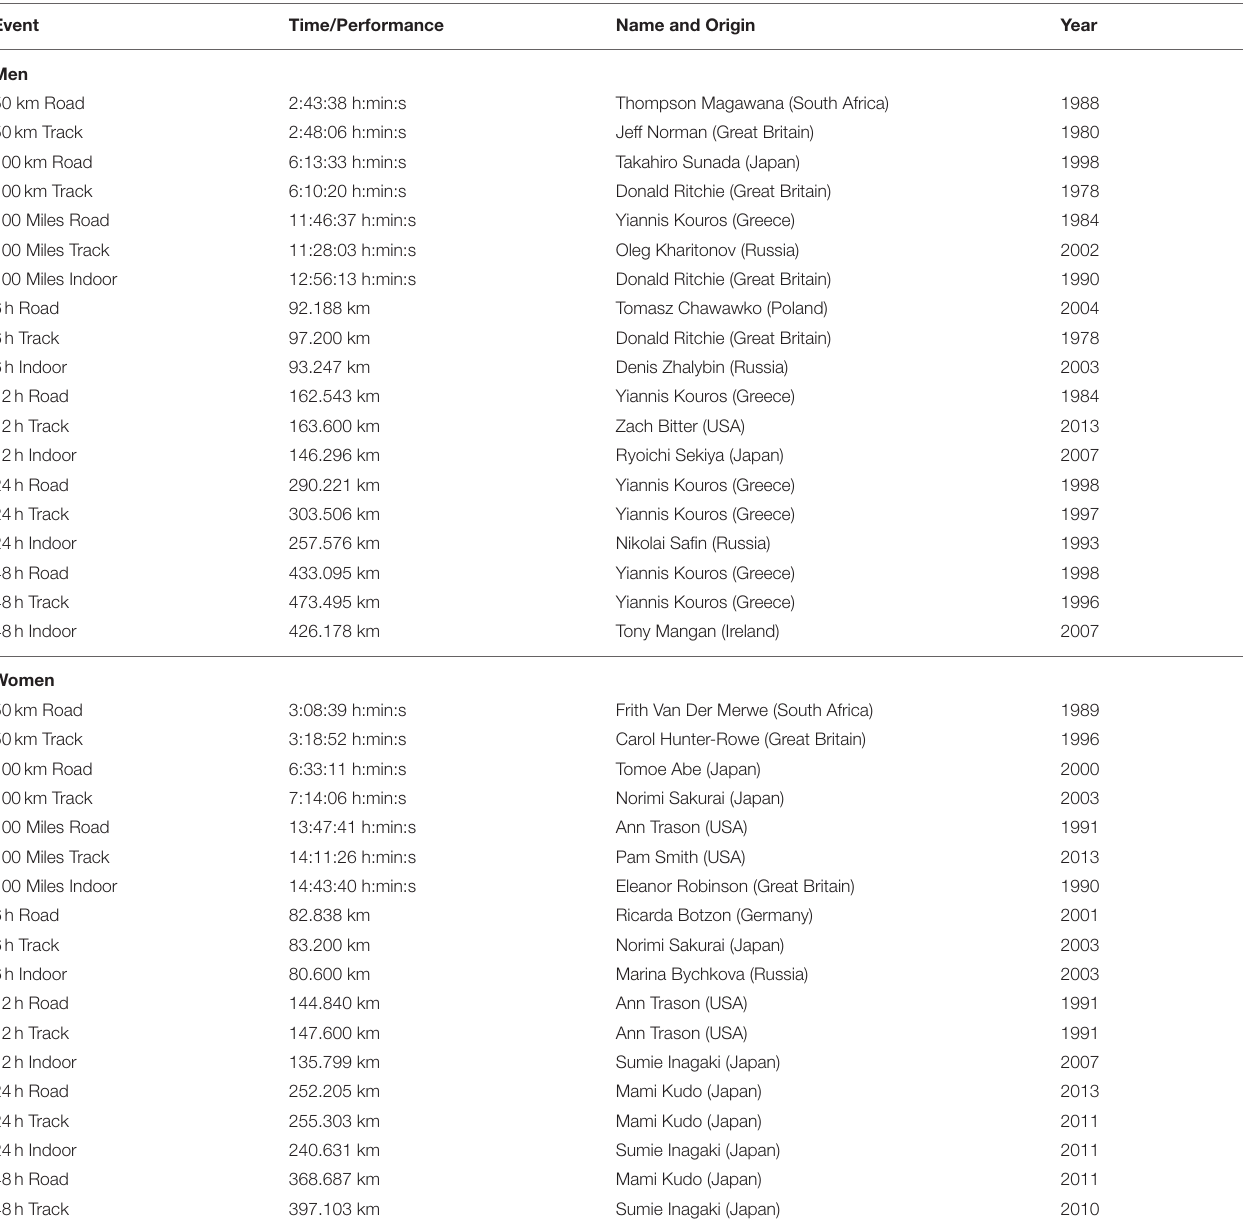
TABLE 6 | World records in men and women in ultra-marathon running following IAU, from